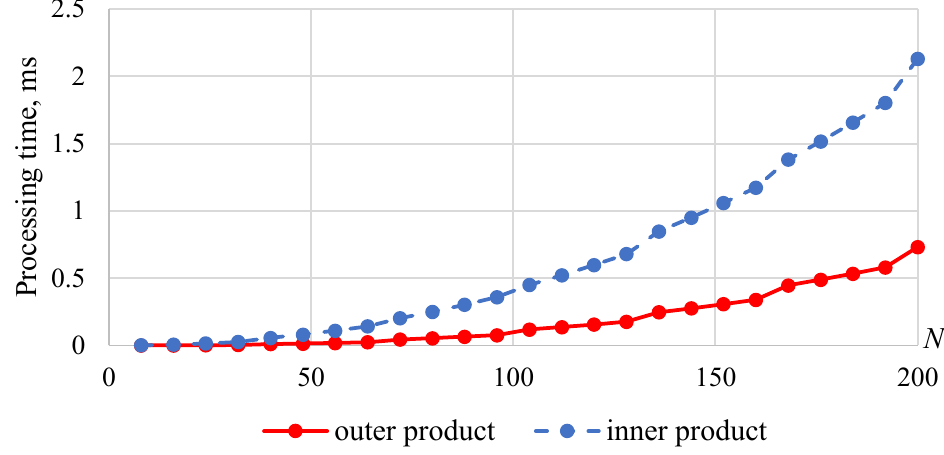
Figure 1. Processing time for matrix multiplication of 16-bit unsigned integers via inner and outer products depending on matrix size.